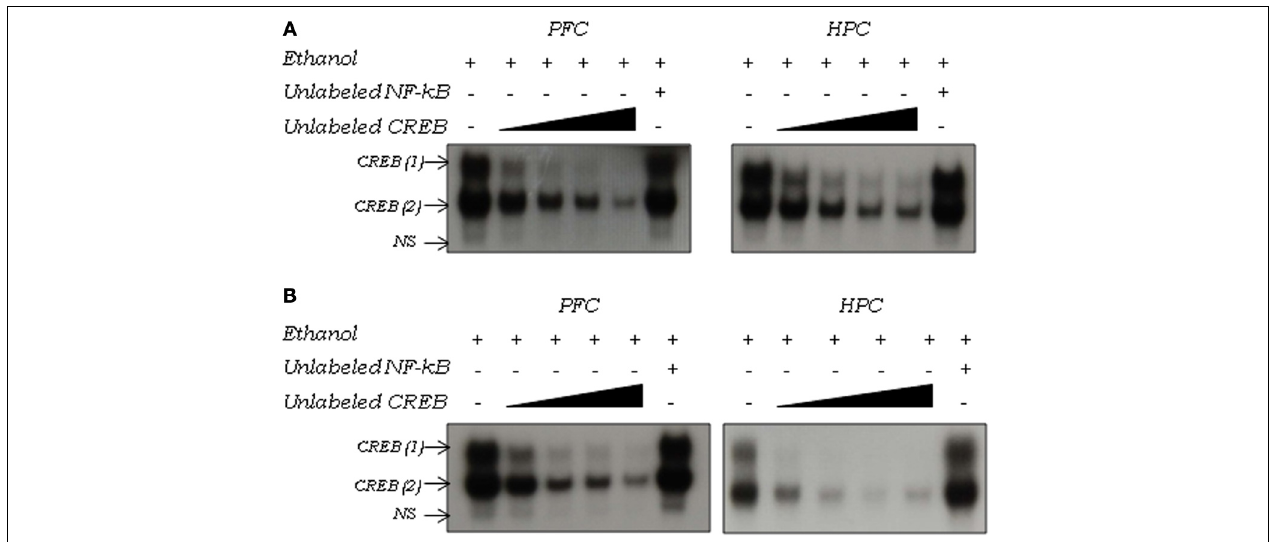
FIGURE 2 | Competition assay of CREB activation induced by ethanol in the prefrontal cortex (PFC) and hippocampus (HPC) in (A) adult and (B) adolescent mice using the EMSA. Nuclear extracts (10 μ g) were obtained 3h after an acute 2.0g/kg ethanol injection. Extracts were incubated in the absence ( − ) or presence